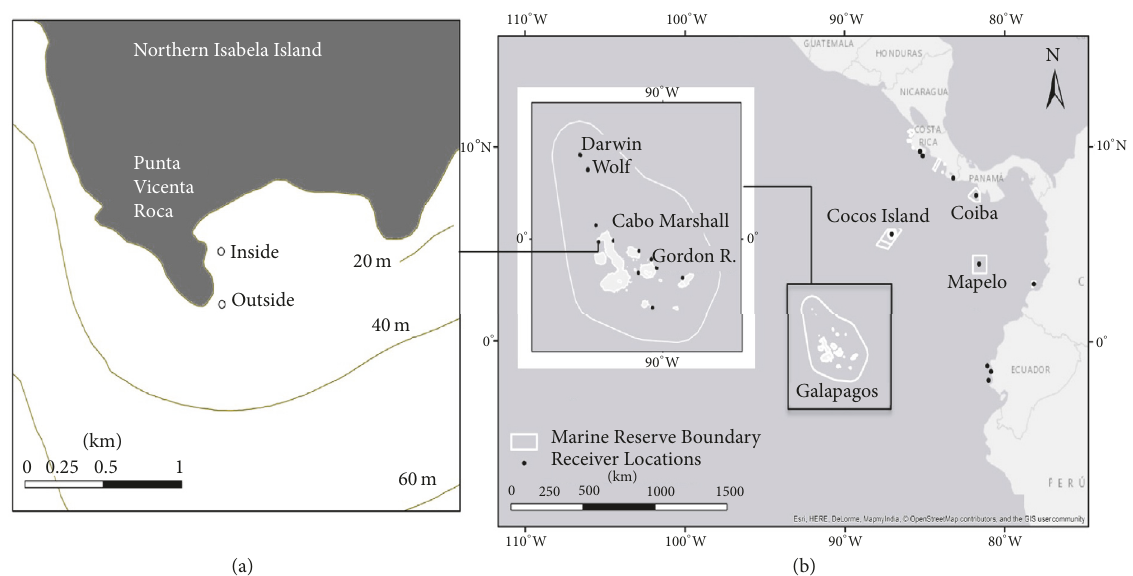
Figure 1: (a) Study site at Punta Vicente Roca, Galapagos, Ecuador. Open circles are the two receivers installed inside and outside the bay at PVR. (b) Black dots indicate receivers in Galapagos and the greater Eastern Tropical Pacific region from Mexico to southern Ecuador. Regional marine protected areas are shown in white